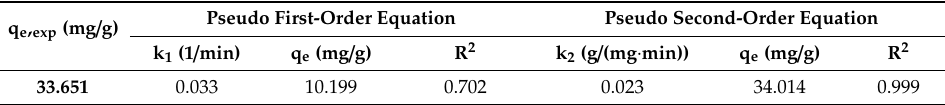
Figure 2. Effect of solvothermal reaction time on the adsorbing capacity ( a ), effect of adsorption time on adsorbing capacity ( b ) , and fitting of Pb(II) adsorption kinetics using pseudo first-order model ( c ) and pseudo second-order model ( d ). Table 1. Kinetic parameters of Pb(II) adsorption at 25 o C.